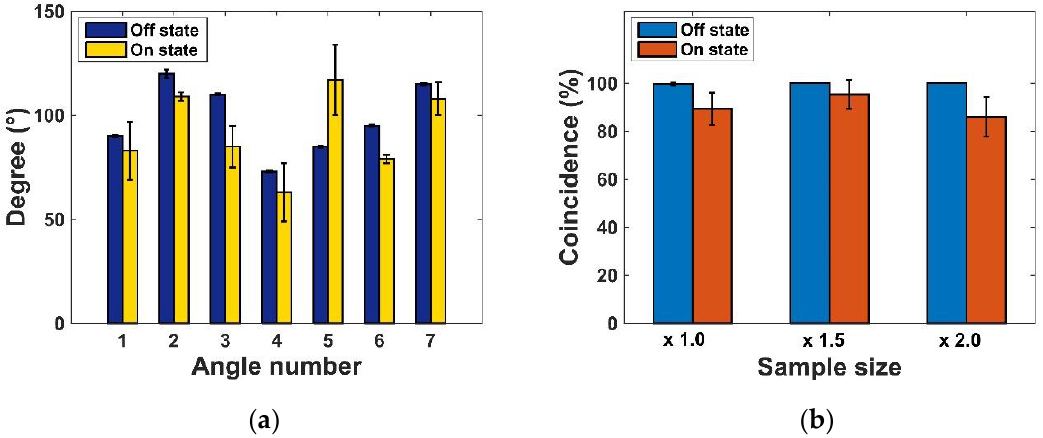
Figure 8. Comparison of angles between joint points of the walking soft robot. ( a ) Joint angle compression result at ×1.0 scale ( b ) Simulation coincidence rate with respect to the sample size.